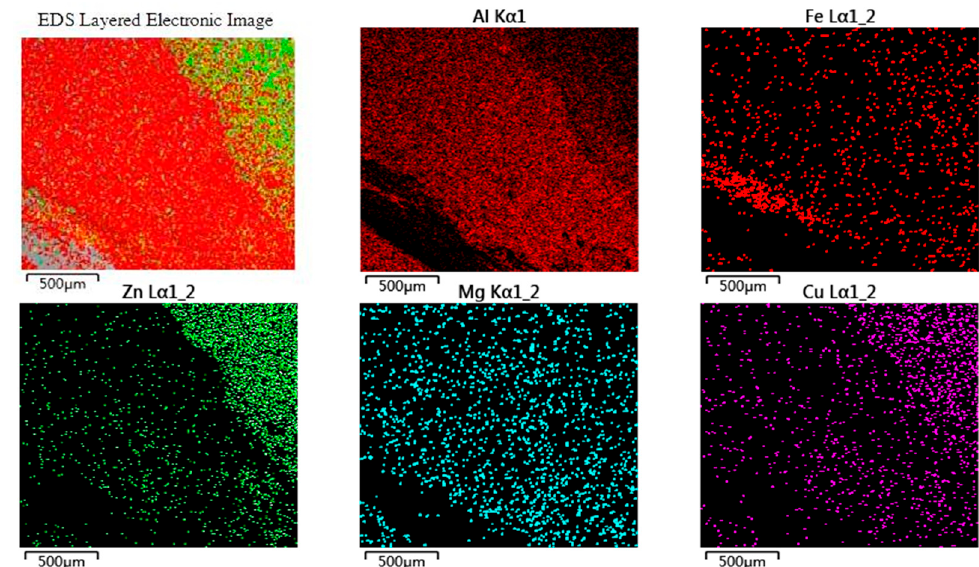
Figure 16. EDS of the surface-scanning analysis of the impact fracture in STZ.